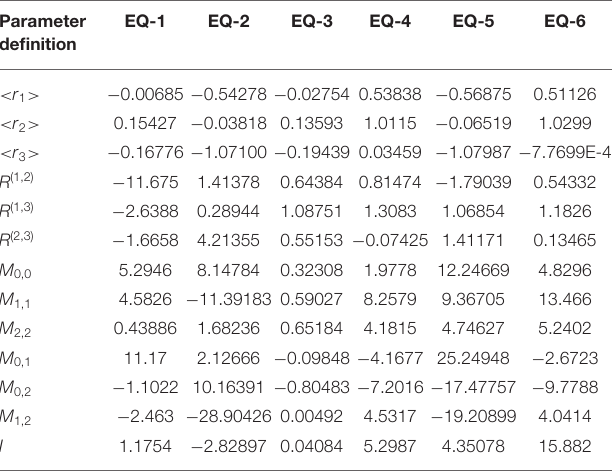
TABLE 2 | The comparison of the 13 basic parameters that correspond to the